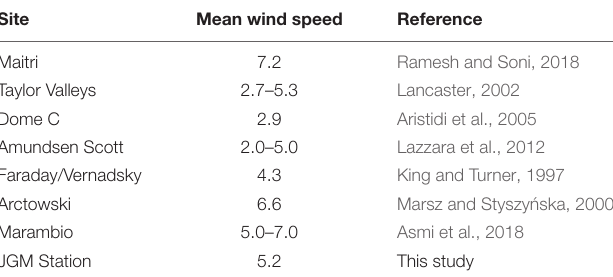
TABLE 2 | Mean wind speed (m s − 1 ) observed at different Antarctic